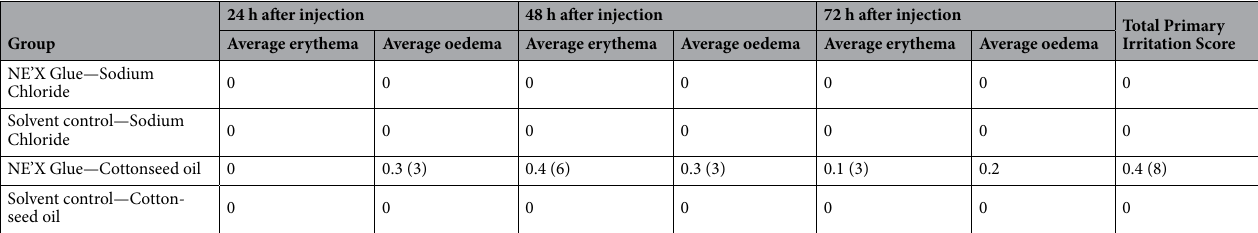
Table 12. Intracutaneous reactivity results.